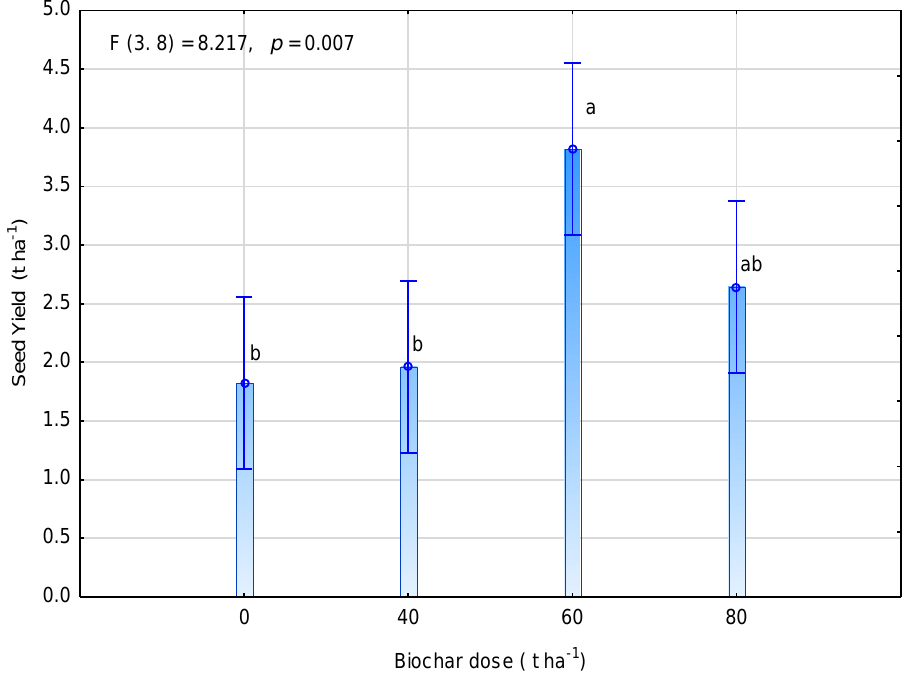
Figure 6. Soybean yield (t ha − 1 ) depending on the level of biochar fertilization. Means labelled with different letters were significantly different for Tukey’s as per test at p < 0.05. Error bars indicate one standard error.